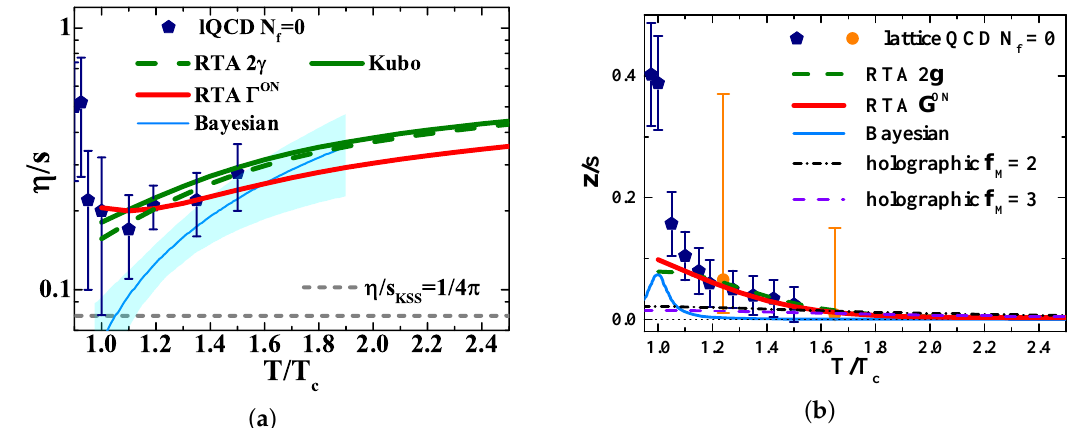
Figure 2. Plot ( a ): the ratio of shear viscosity to entropy density as a function of the scaled temperature T / T c for µ B = 0 calculated using the Kubo formalism (green solid line) and the RTA approach with the interaction rate Γ on (red solid line) and the DQPM width 2 γ (dashed green line). The dashed gray line demonstrates the Kovtun–Son–Starinets bound [33] ( η / s ) KSS = 1/ ( 4 π ) , and the symbols show lQCD data for pure SU(3) gauge theory taken from Ref. [34] (pentagons). The solid blue line shows the results from a Bayesian analysis of experimental heavy-ion data from Ref. [35]. Plot ( b ): the ratio of the bulk viscosity to entropy density ζ / s as a function of the scaled temperature T / T c for µ B = 0 calculated using the RTA approach with the on-shell interaction rate Γ on (red solid line) and the DQPM width 2 γ (dashed green line). The symbols correspond to the lQCD data for pure SU(3) gauge theory taken from Refs. [36] (pentagons) and [37] (circles). The solid blue line shows the results from a Bayesian analysis of experimental heavy-ion data from Ref. [35]. The dot-dashed and dashed lines correspond to the results from the non-conformal holographic model for φ M = 2 and 3, correspondingly, from Ref.